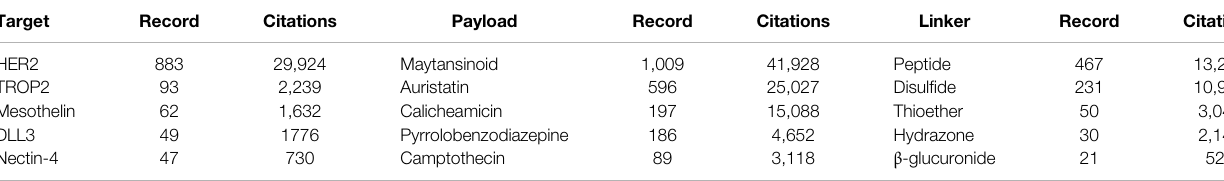
TABLE 6 | The top fi ve most investigated targets, payloads, and linkers of